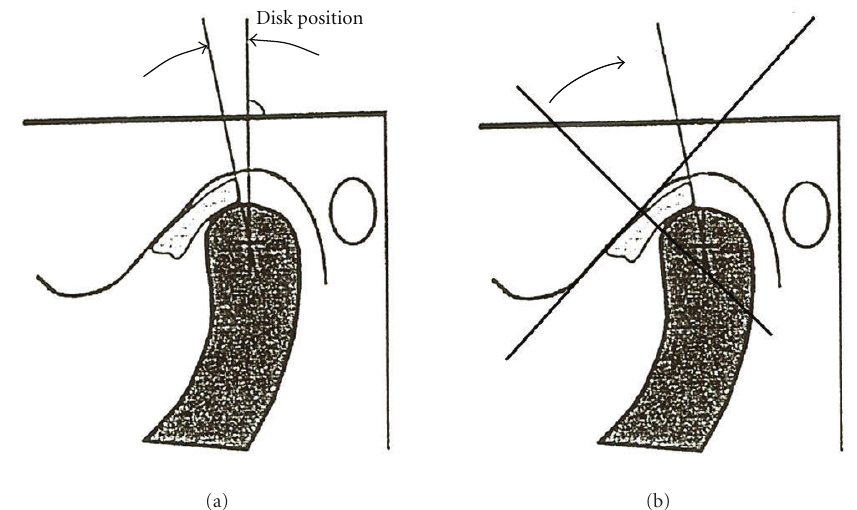
Figure 2: Protocols for diagnosis of anterior disc displacement. Angular measurement of disc position using the standard protocol (a) and the alternative protocol (b). In the standard protocol (on (a)), the posterior band of the disc is compared to the 12 o’clock position through the head of the condyle. In the alternative protocol (on (b)), the posterior band of the disc is compared to a line perpendicular to the tangent of the slope of the posterior eminence. The tangent used to represent the slope of the articular eminence was drawn superiorly between the 12 o’clock position at the most posterior part of the glenoid fossa of the temporal bone and anteriorly at the most inferior posterior point at the base of the articular eminence based on diagrams from